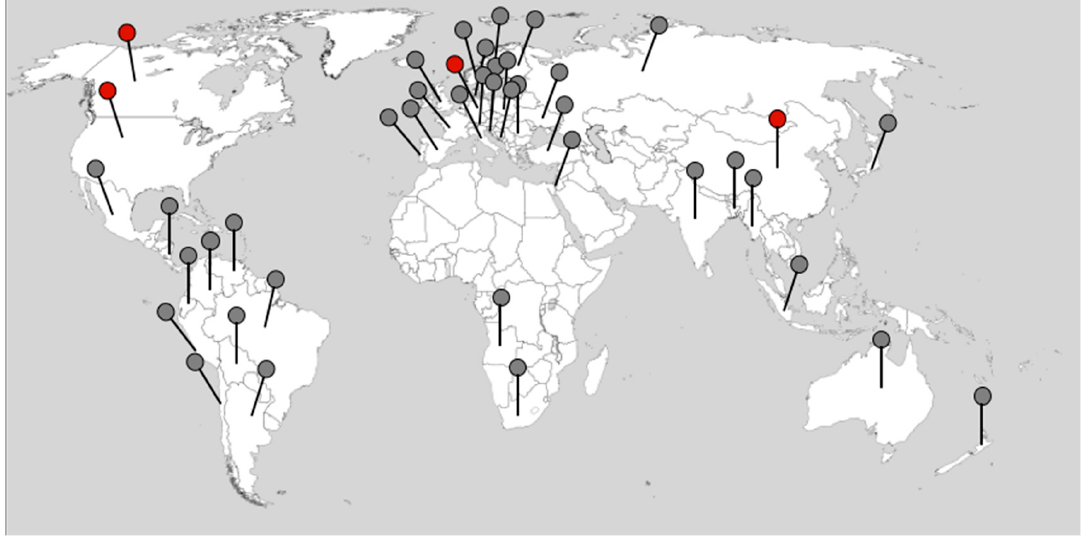
Figure 1. The worldwide distribution of P. brassicae (based on references until the beginning of 2022). The dots show all countries where the occurrence of P. brassicae was reported. The red dots indicate the geographical origin of those where sequence information is available (based on information beginning in 2022). The map is from https://d-maps.com/carte.php?num_car=13180&lang=de (accessed on 25 February 2022).